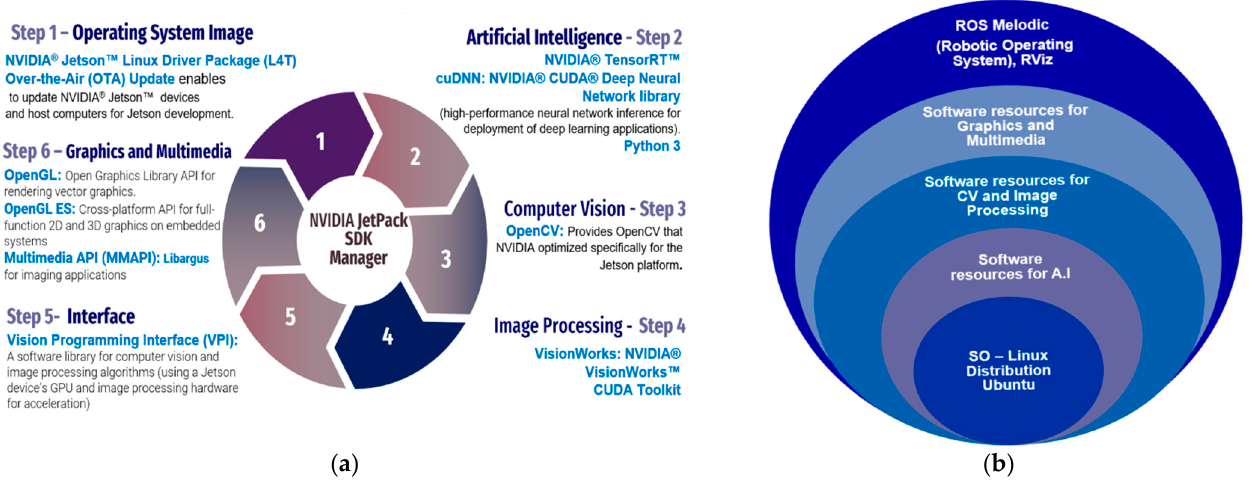
Figure 8. Software architecture of the proposed mechatronic system. ( a ) Software resource packages (NVIDIA JetPack SDK) required for the operation of the Jetson Nano platform; ( b ) software archi- tecture of the proposed mobile mechatronic system with Jetson Nano Developer Kit and ROS Melodic.